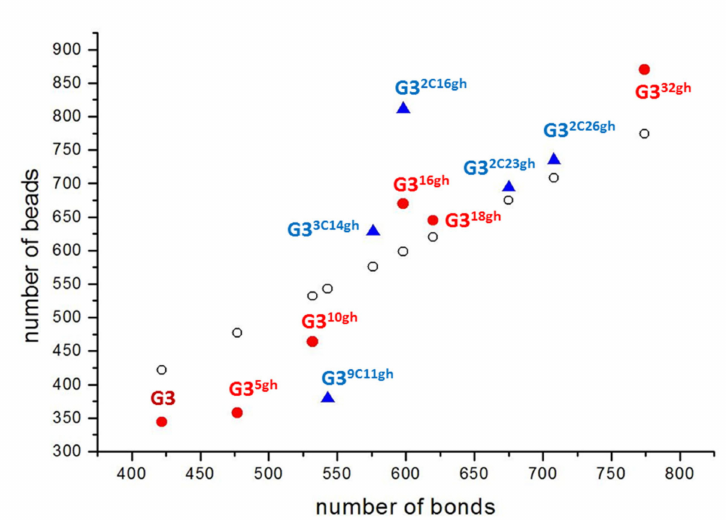
Figure 9. Collective graph illustrating the number of beads derived from ∆ C p at T g for G ngh (red circles) and for G mCngh (blue triangles) conjugates: For comparison, the number of freely rotating bonds are represented by open circles for given compound. All C–C, C–N, and C–O bonds were considered as freely rotating, including amide bonds except the internal bonds of cytisine, and are summarized to give the reference points which lay on the line with slope =